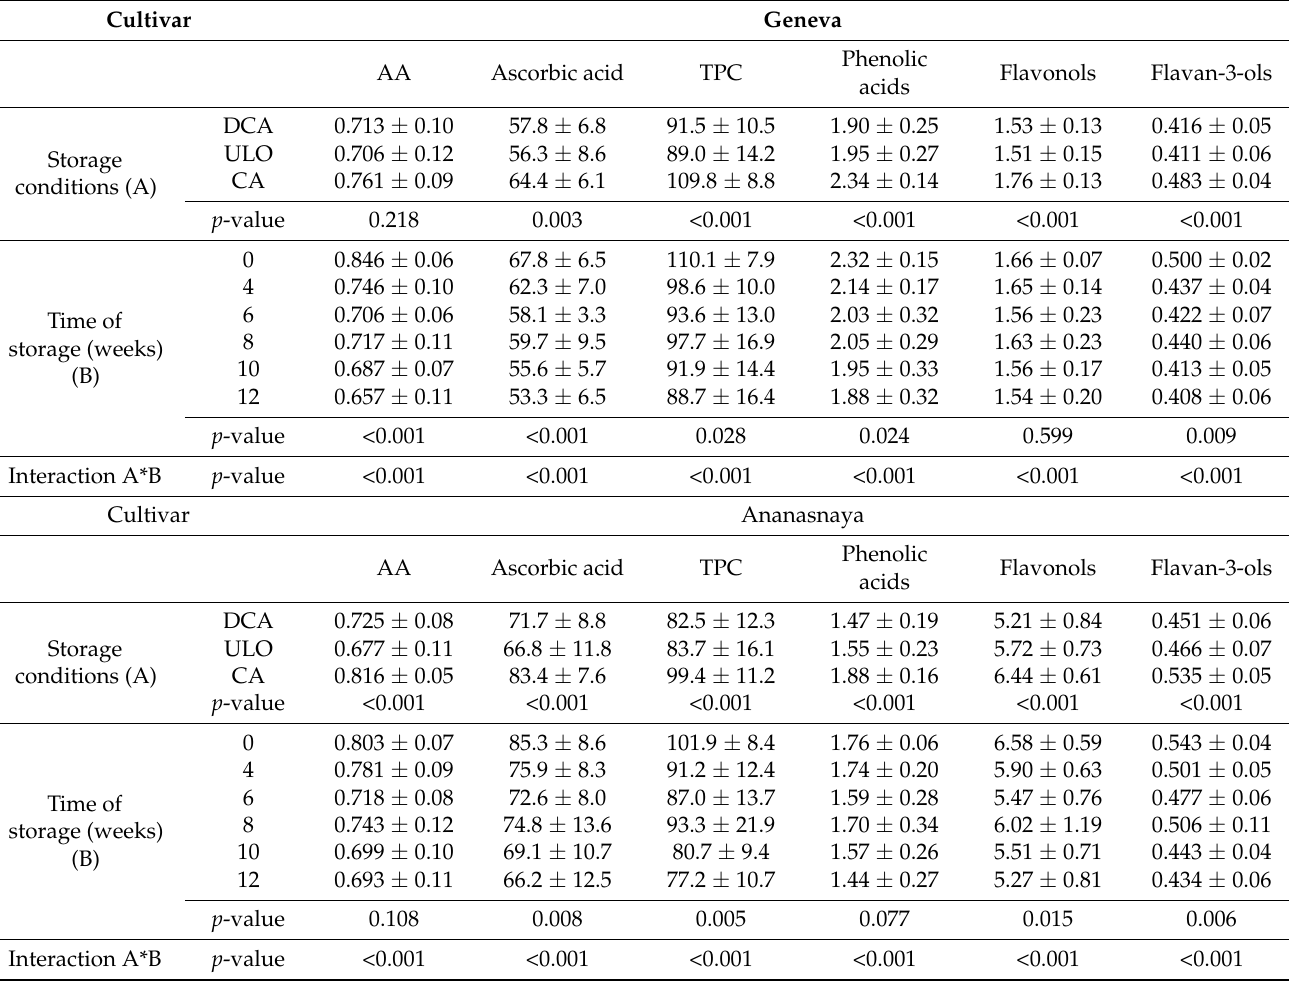
Table 2. Changes in antioxidant activity (mg vit C · 100 g − 1 F.W.) and ascorbic acid and